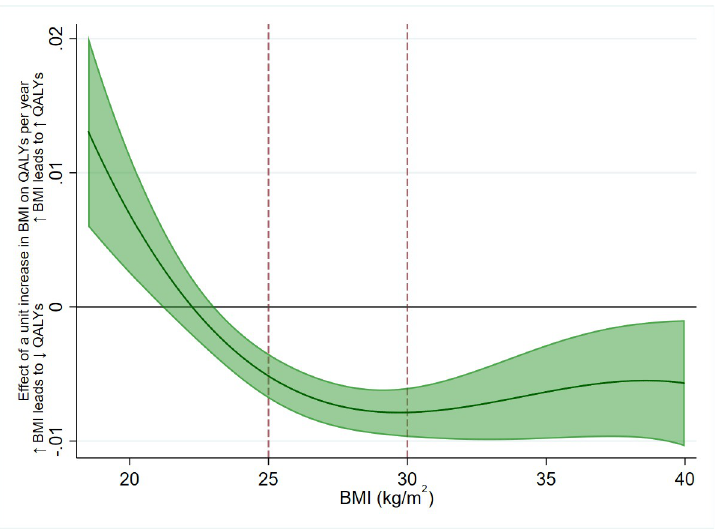
Fig 4. The estimated effect of 1-kg/m 2 increase in BMI on QALYs per year, across BMI levels. A positive value indicates an increase in BMI would increase QALYs, and vice versa. An increase in BMI is beneficial to QALYs up to around 22 kg/m 2 , then becomes increasingly detrimental until the effect plateaus in overweight and remains relatively steady in obesity. The BMI thresholds of 25 kg/m 2 (overweight) and 30 kg/m 2 (obese) are represented with dashed red lines. The green shaded area represents the 95% CI of the estimated effect. Effect estimates are derived from the nonlinear imputation model. BMI, body mass index; CI, confidence interval; QALY, quality-adjusted life year. https://doi.org/10.1371/journal.pmed.1003725.g004 estimates were larger for QALYs and similar for costs, both with greater precision. Full results are in S13 and S14 Tables .